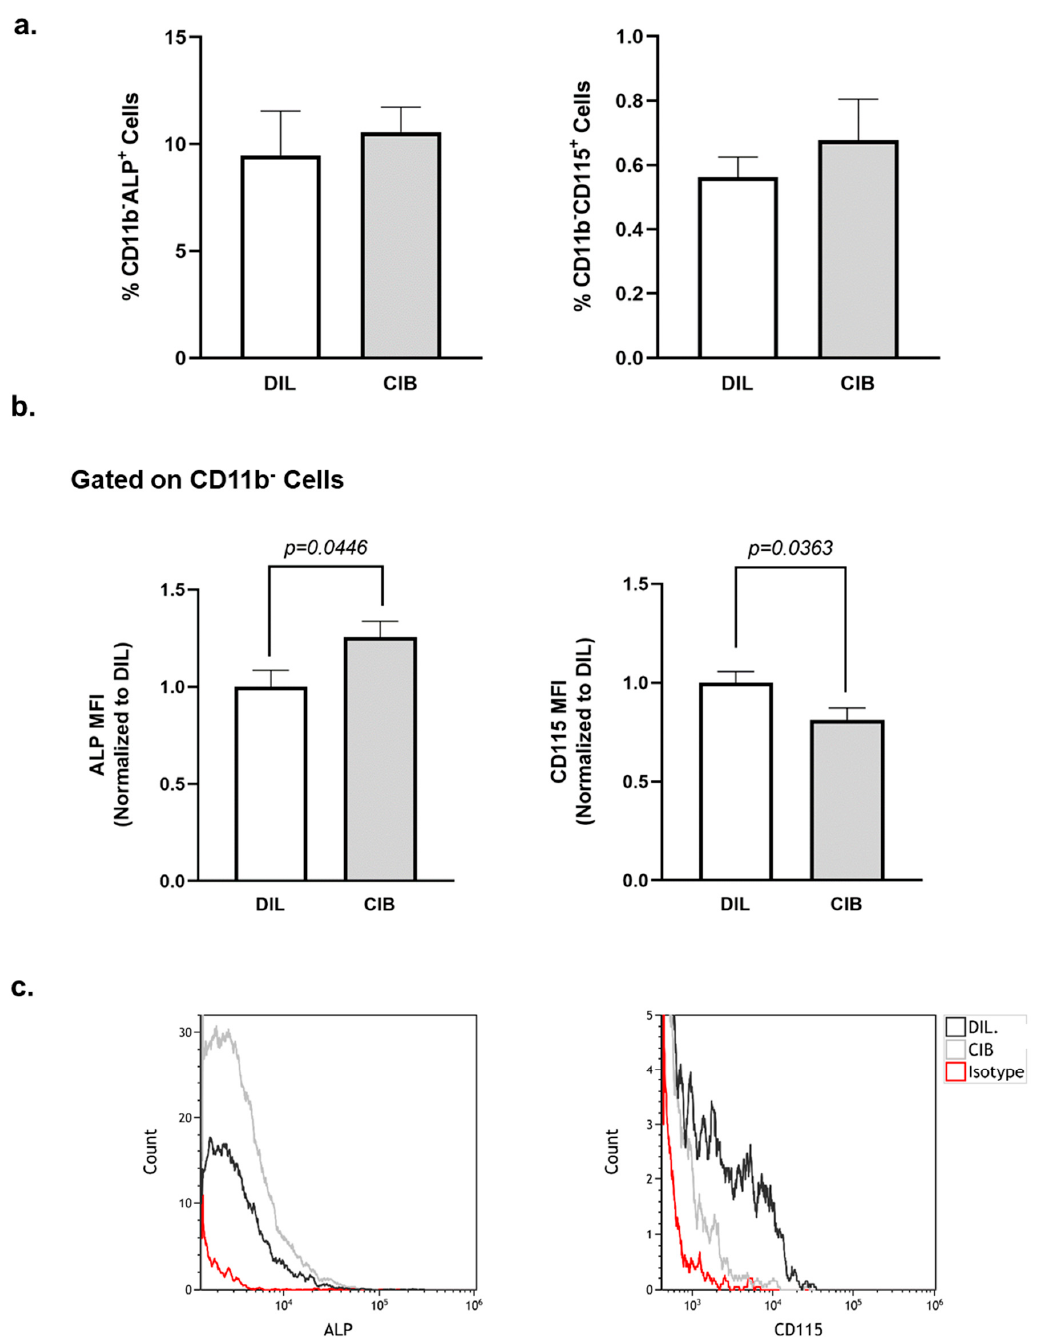
Figure 6. In vivo effects of Cibinetide (CIB) on bone cell precursors. Flow cytometry analysis of osteoblast (CD11b - ALP + ) and osteoclast precursors (CD11b - CD115 + ) of total bone marrow from diluent and Cibinetide injected mice. ( a ) Percentage of cells in the bone marrow. ( b ) Surface expression (mean fluorescence intensity (MFI)) of ALP and CD115 on CD11b - cells in Cibinetide vs. diluent treated mice. ( c ) Representative overlay histograms of ALP and CD115 expression on CD11b - cells. The data are mean ± SEM. N = 9–10 mice in each group.